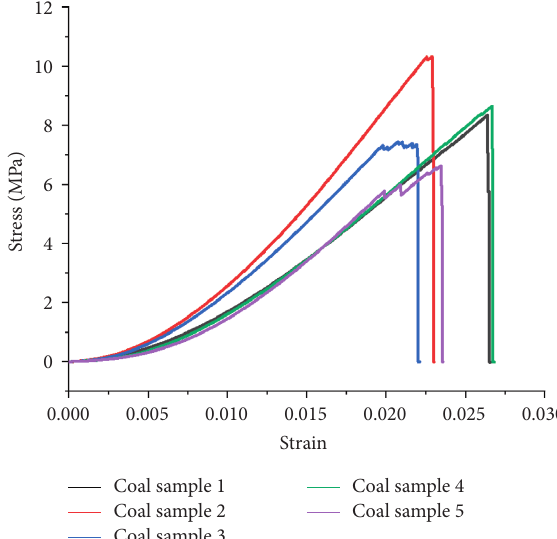
Figure 12: Uniaxial compressive strength of different coal